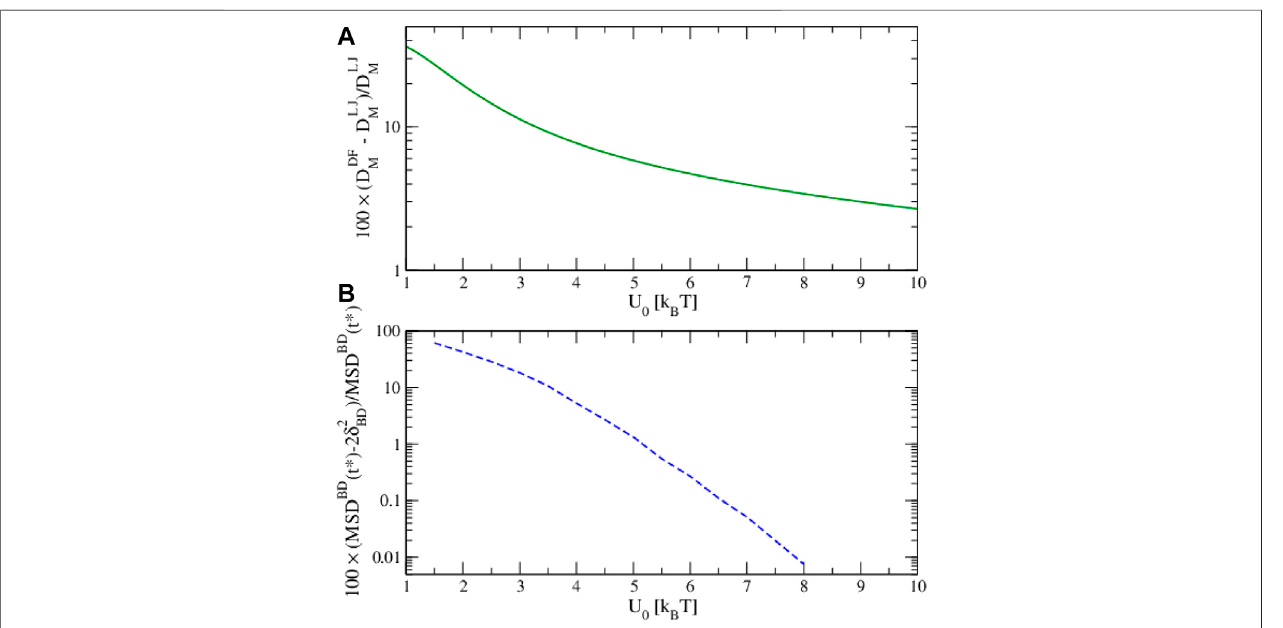
FIGURE 15 | (Color online): (A) Error of the long-time diffusion coef fi cient obtained from the Dalle-Ferrier formula D DF M regarding the value predicted by the Lifson- Jackson D LJ M prescription,and (B) differencebetweenthe fi ttingBellourparameter2 δ 2 andthemeansquaredisplacementatthecriticaltime MSD ( t p ) asafunctionofthe maximum height barrier U 0 . These results were obtained from Brownian dynamics simulations in which L (cid:2) 1 . 0 × 10 − 6 m and D 0 (cid:2) 1 . 8 × 10 − 13 m 2 / s in all